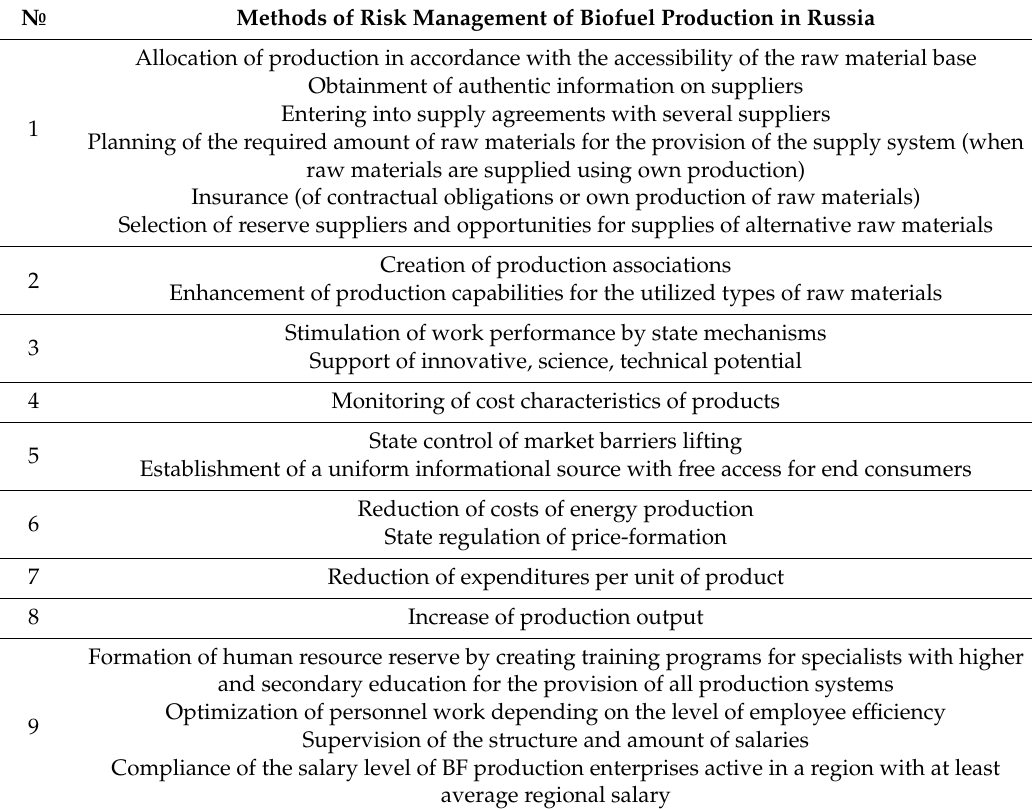
Table 2. Methods of risk management of biofuel production in